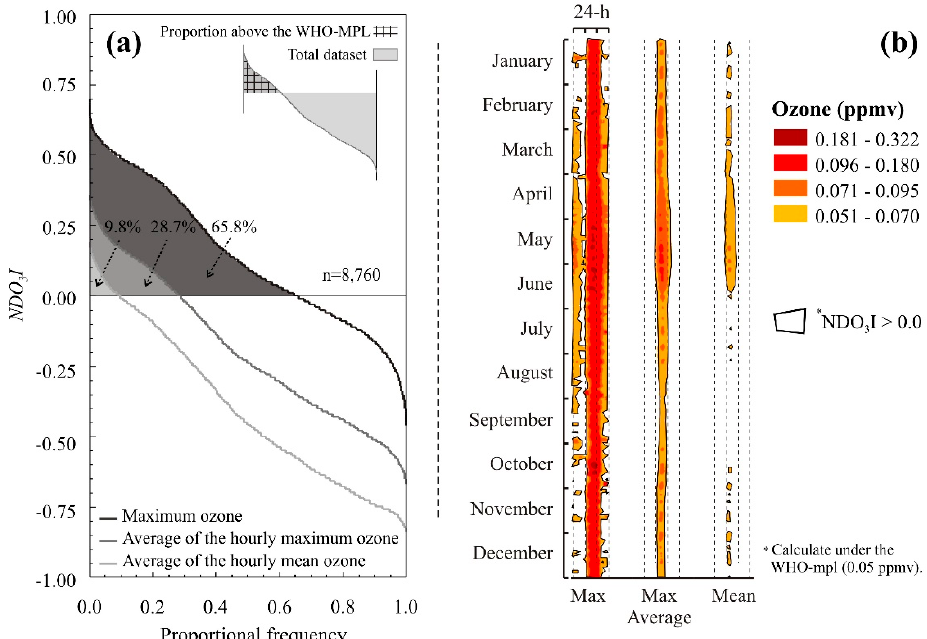
Figure 9. ( a ) Percentage of hourly ozone observed above the WHO guideline in terms of the NDO 3 I. ( b ) Normal variation over nineteen years of the hourly tropospheric ozone through the annual cycle given the three different statistical parameters. Abbreviation: normalized difference ozone index, NDO3I; maximum permissible limit, MPL.